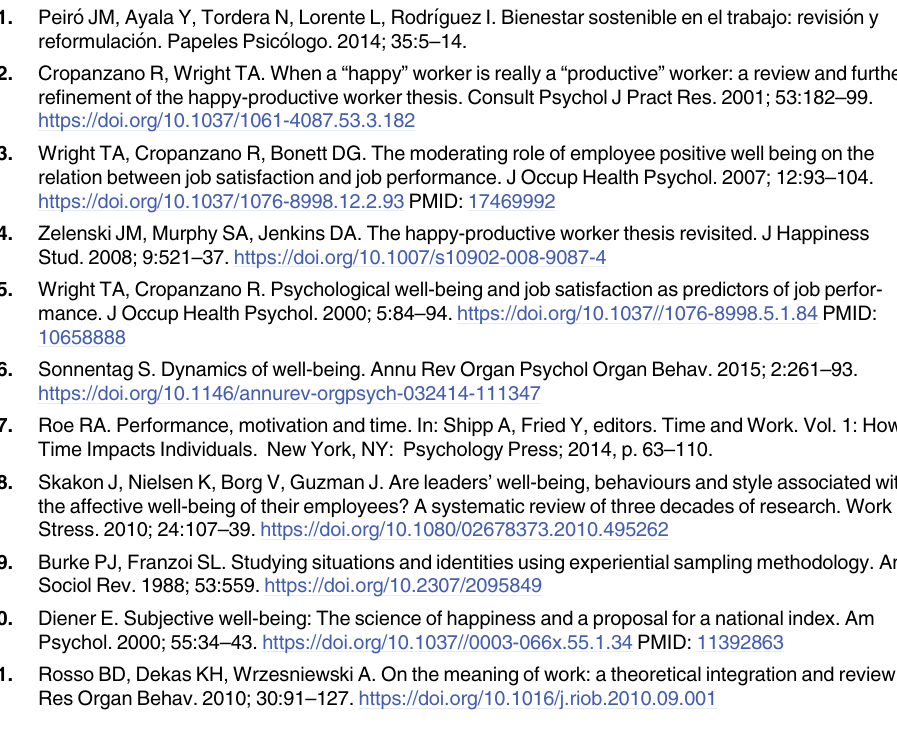
S1 Table. Descriptive statistics and correlations for hedonic well-being, eudaimonic well- being, and extra-role